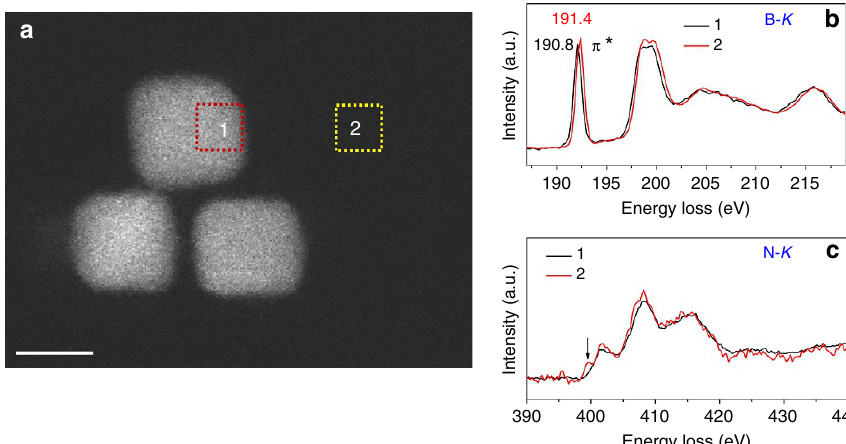
Figure 3 | EELS analysis of Pt/ h -BNNS. ( a ) Annular dark-field (ADF) STEM image of Pt/ h -BNNS indicating the mapping region: 1. The centre of Pt/ h -BNNS overlapping region; 2. h-BNNS matrix. ( b ) B- K EELS profile and ( c ) N- K EELS profile mapped from regions 1 and